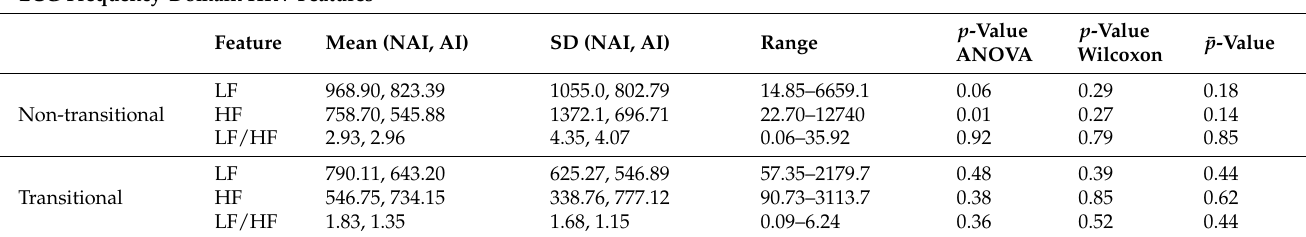
Table 3. ECG frequency domain HRV features. Note: low-frequency: LF [ms 2 ] (non-anxiety- induced/anxiety-induced); high-frequency: HF [ms 2 ]; LF/HF ratio: LF/HF; non-anxiety-induced (NAI); anxiety-induced (AI).